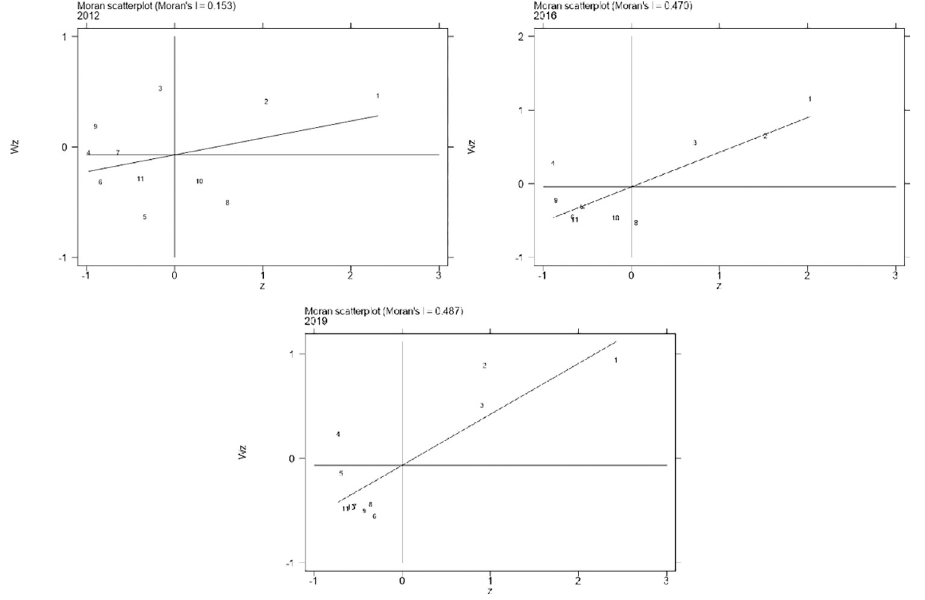
Fig 4. Partial Moran’s I scatter